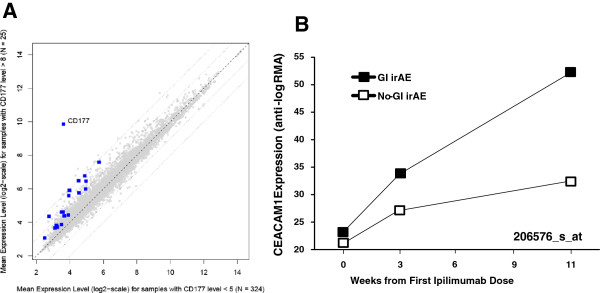
Expression of granule-associated genes. (A) Mean expression level for samples with high CD177 expression (> 256) versus that for samples with low CD177 expression (< 32), for each of the 9697 probe sets passing the low-expression filter. Each point represents one probe set. Blue squares highlight CD177 and 19 probe sets for 13 unique neutrophil granule-associated genes. Diagonal reference lines indicate mean expression ratios of 4, 2, 1, 0.5, and 0.25. Expression of genes with points above the central dashed line was positively associated with CD177 expression. (B) Mean gene expression (anti-log RMA-normalized value) of CEACAM1 (probe set: 206576_s_at) during ipilimumab treatment in patients with (GI irAE) or without (No-GI irAE) a grade 2 or greater GI irAE.